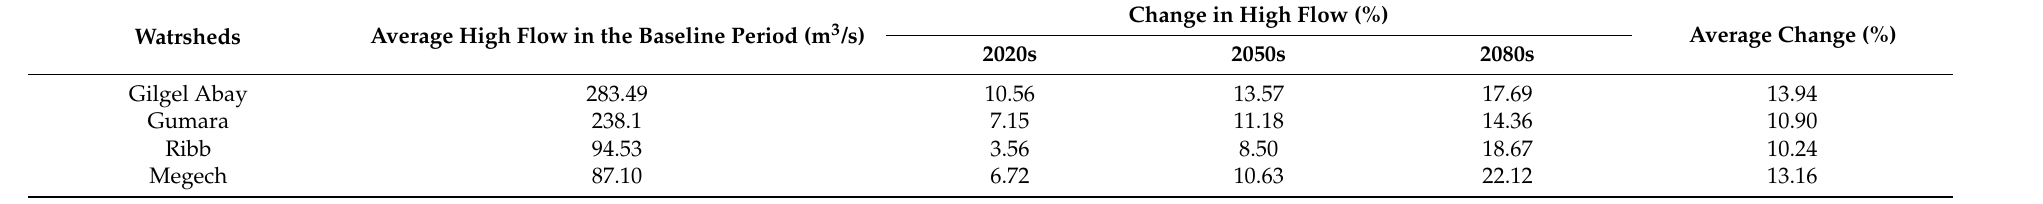
Table 9. The mean annual maximum flows of watersheds in the range of probability of exceedance in the ensemble mean of six climate models.